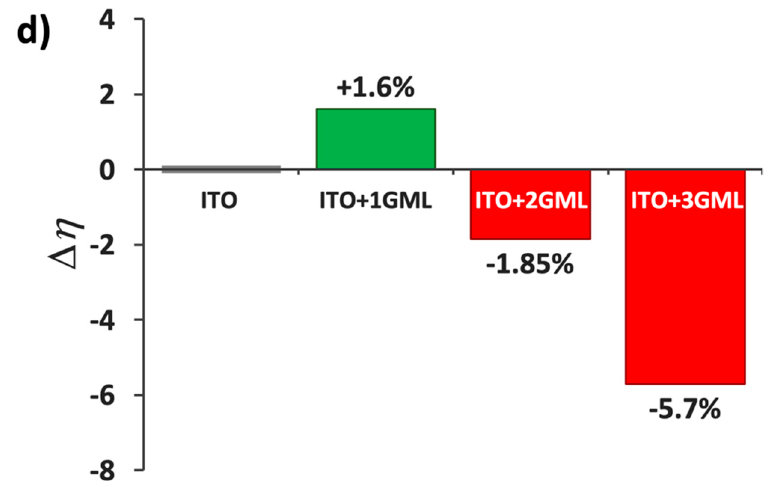
Figure 6. Solar cell parameter variations ( J sc ( a ), FF ( b ), R s ( c ) and overall efficiency η ( d )) observed as the front ITO is substituted by a hybrid TCE consisting in an ITO layer covered with one, two or three graphene monolayers.